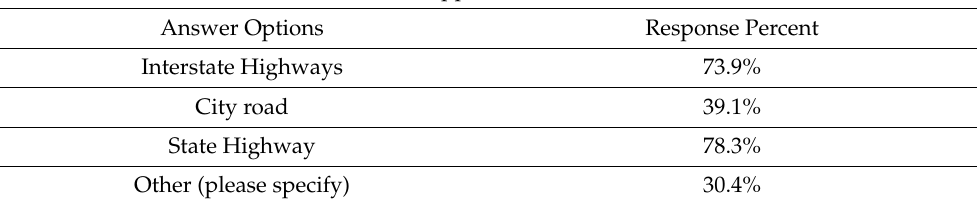
Table 13 reflects the types of processes used by state DOTs in order to incorporate